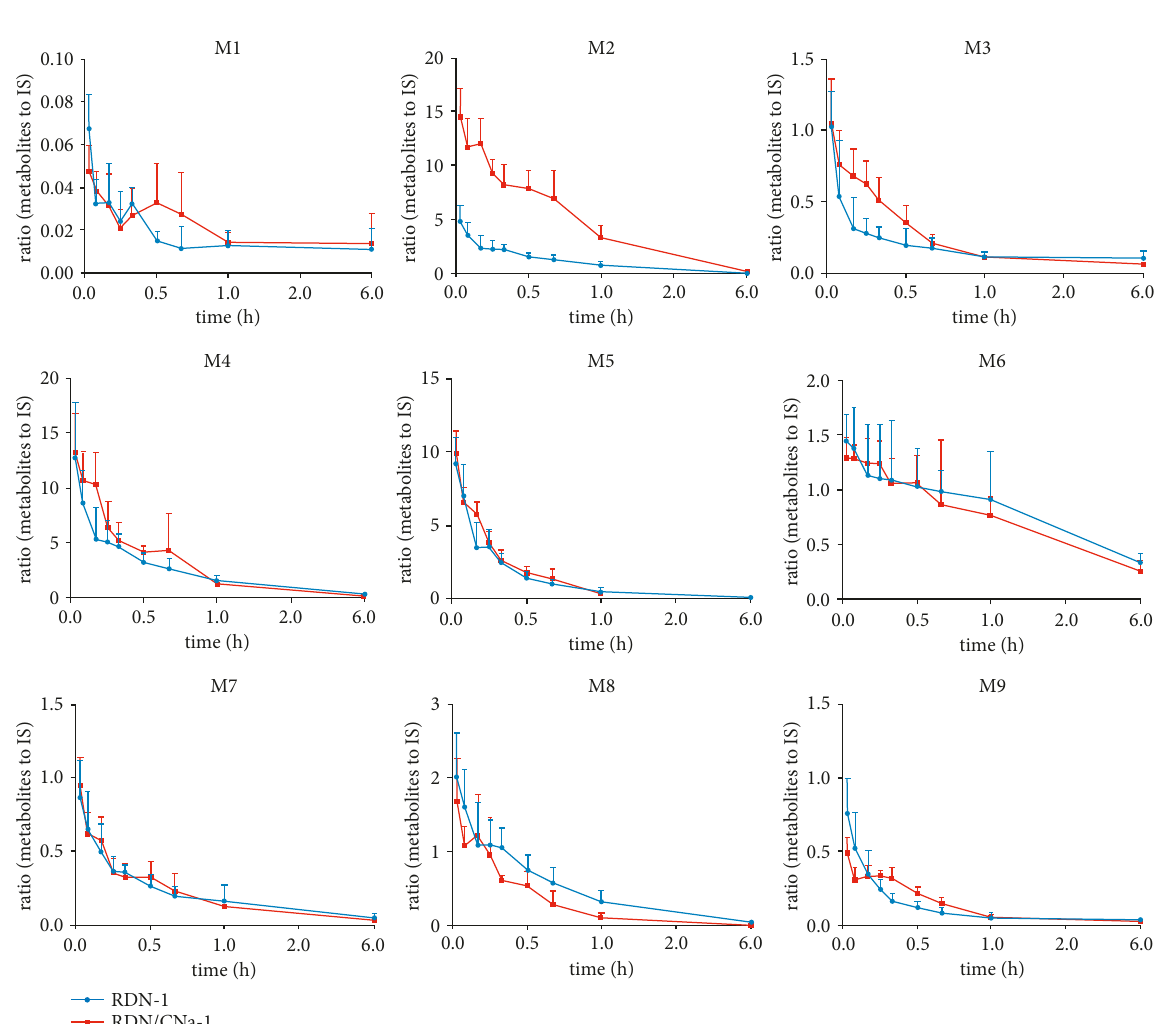
Figure 8: The curves of relative changes of the metabolites during 6h after single